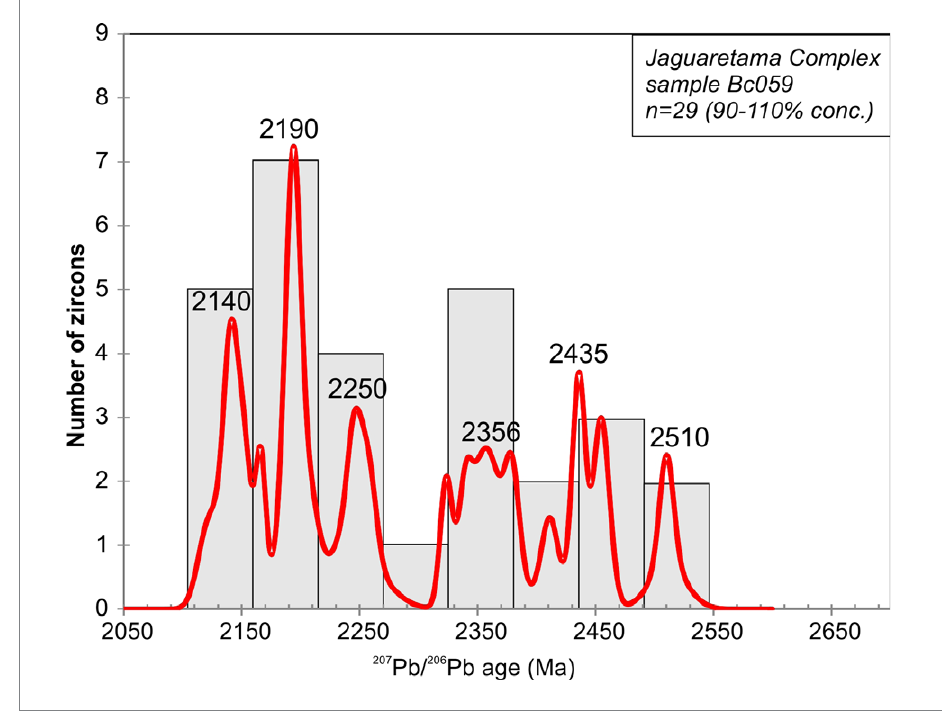
FIGURE 5 – Frequency histograms and probability plot of 207 Pb/ 206 Pb detrital zircon ages (90-110%